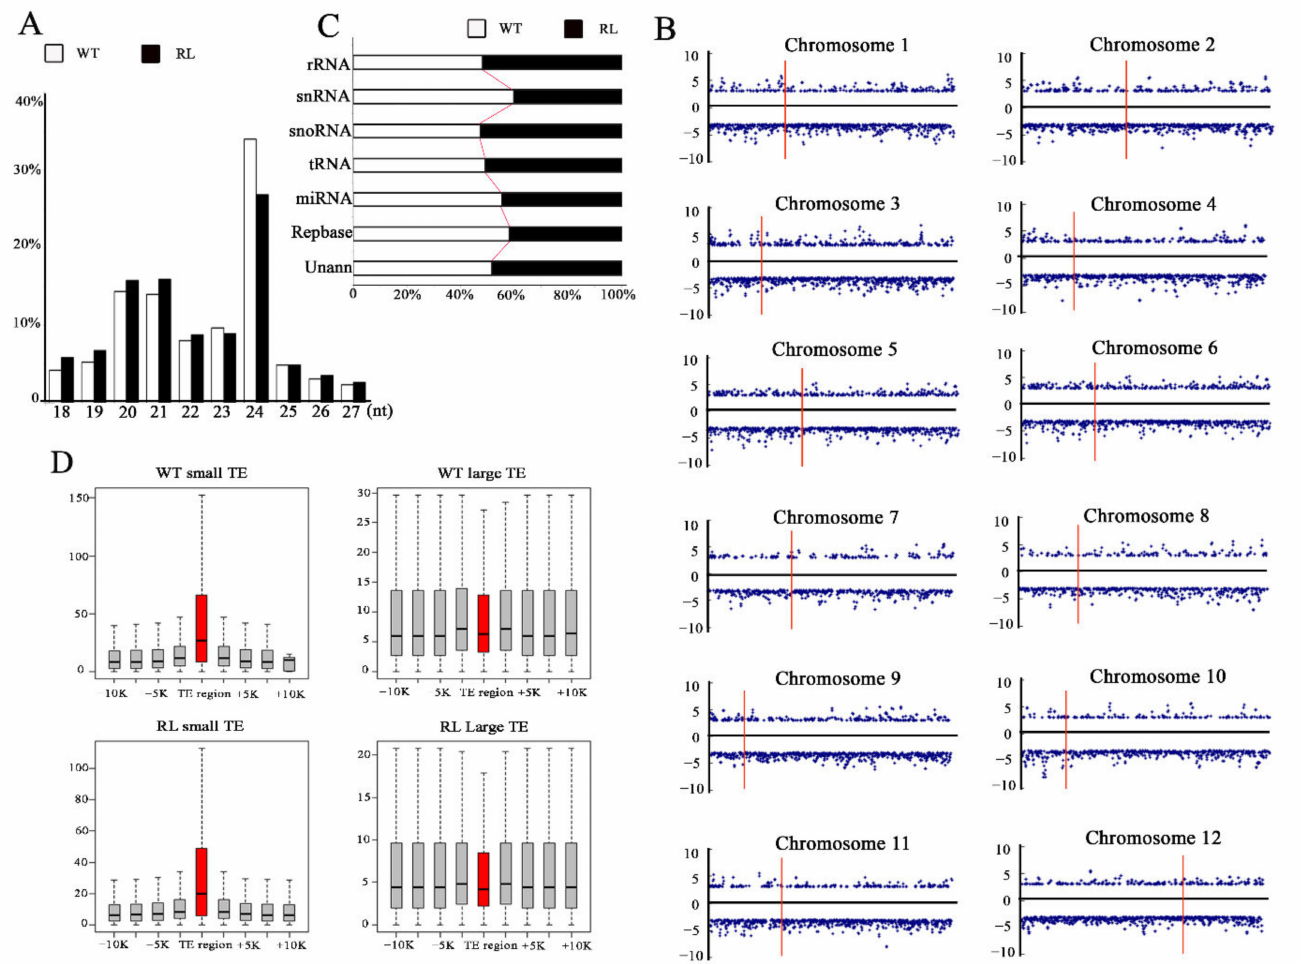
Figure 3. Genome-wide small RNA expression alteration between RL and its donor WT. ( A ) Size distribution (18 nt–27 nt) of small RNAs in WT and RL. ( B ) Distribution of small RNA cluster variation between RL and WT across rice genome. x axis represents chromosome length, y axis represents the fold difference of RPM value (log value, base2). ( C ) The relative proportion of different categories of small RNAs in WT and RL. ( D ) Box plots showing the distribution of small RNA sequences (removed tRNA, rRNA, miRNA, snRNA and snoRNA) mapped to small/large TE region and their flank region (~10 kb) in RL and